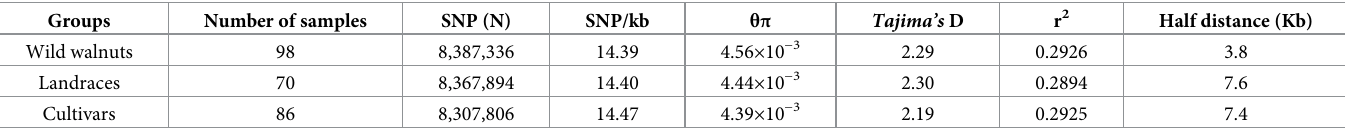
Table 1. Nucleotide diversity and linkage disequilibrium (LD) decays in wild walnuts, walnut landraces, and walnut cultivars. Groups Number of